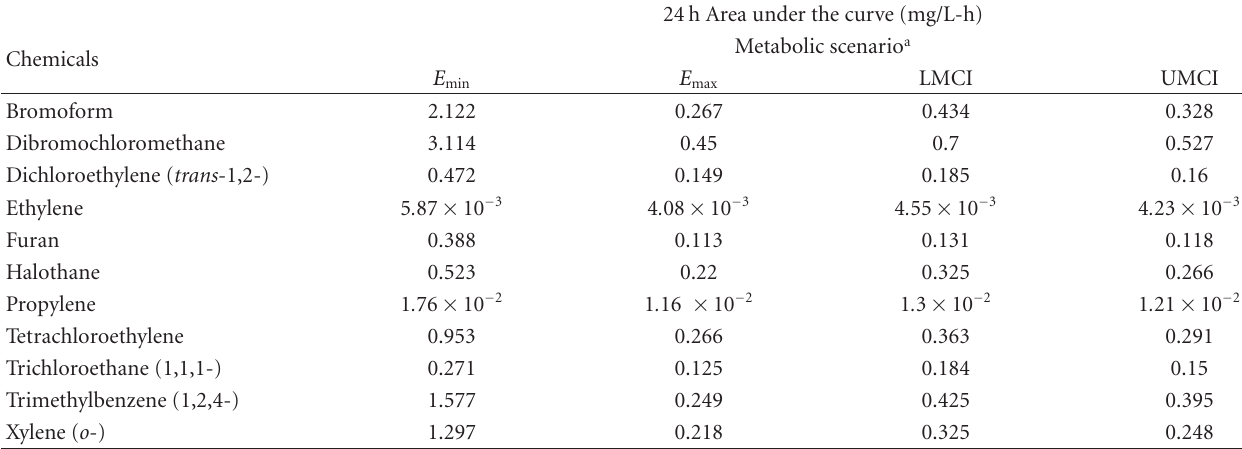
Table 6: Area under the curve for four metabolic scenarios, for VOCs in the evaluation dataset. 24 h Area under the curve (mg/L-h)